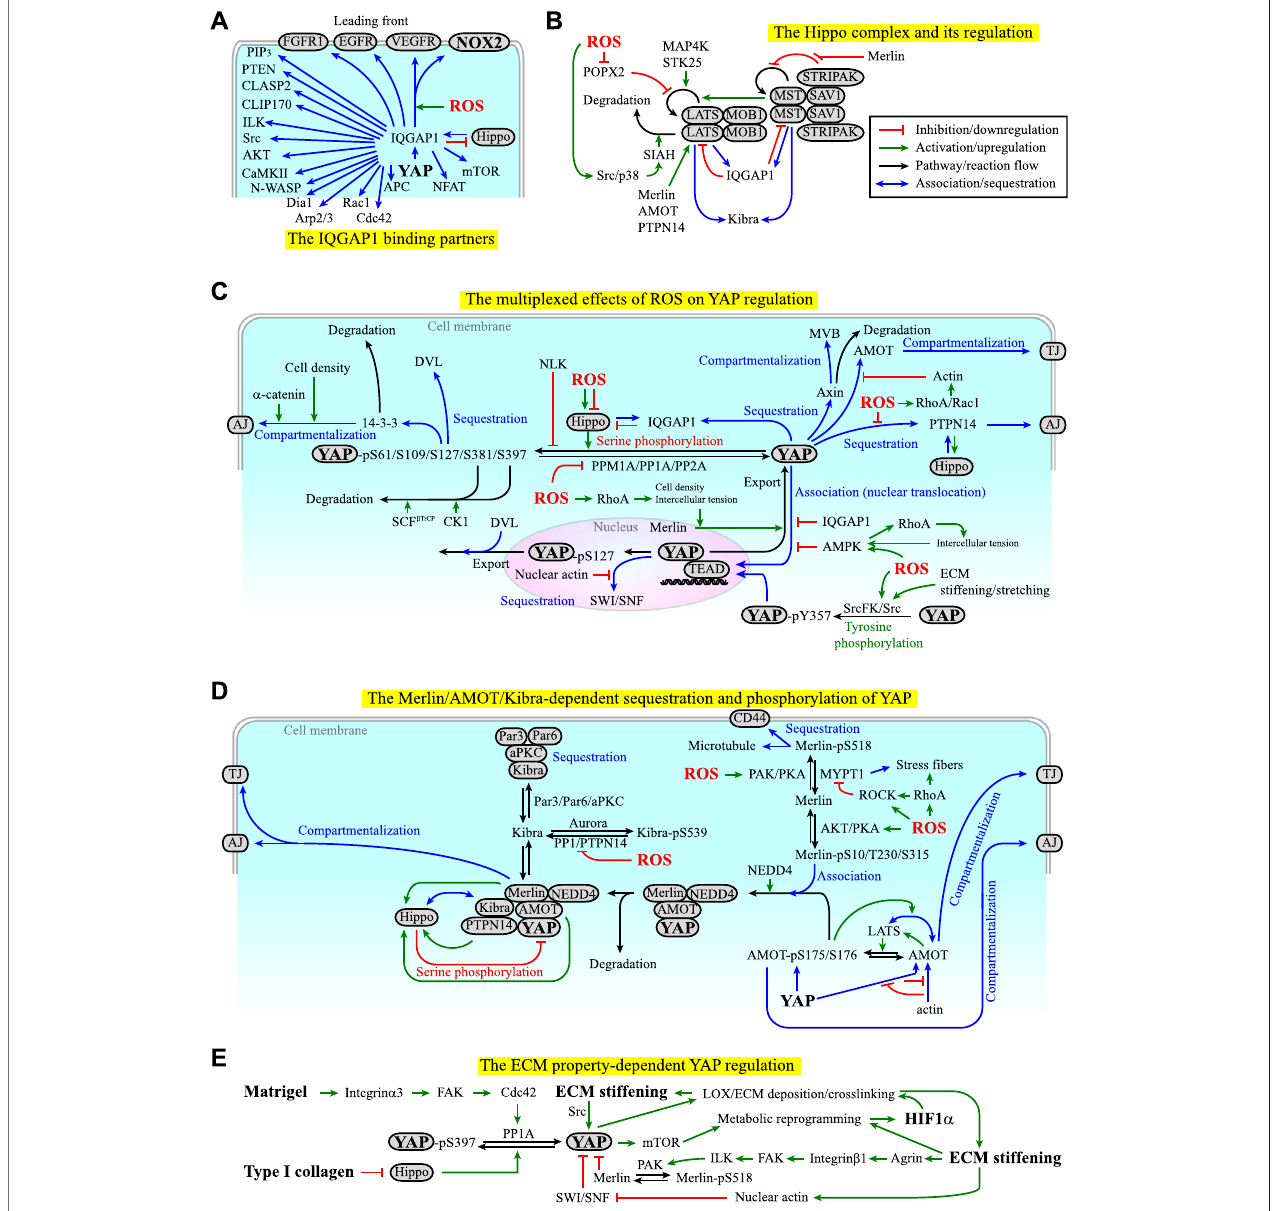
FIGURE 4 | (A) Examples of the binding partners of IQ motif-containing GTPase activating protein 1 (IQGAP1). Red lines indicate inhibition or downregulation. Green lines indicate activation or upregulation. Blue lines indicate physical association or recruitment. See Module Boxes IV and V for details. (B) The Hippo complex is regulatedbyitselfandseveralkinases,phosphatases,andmolecularscaffoldsinaROS-dependentmanner.SeeModuleBoxVfordetails.Blacklinesindicatethe fl owof the pathways, cascades, or a reaction. (C) ROS exhibit both positive and negative effects on the regulation of YAP signaling manifested in the phosphorylation, dephosphorylation, sequestration, degradation, and compartmentalization of YAP. Red texts indicate inhibition. Blue texts indicate sequestration, association, or compartmentalization. Green texts indicate activation. (D) Merlin, angiomotin (AMOT), kidney and brain expressed protein (KIBRA), and protein tyrosine phosphatase non-receptortype14(PTPN14)actwiththeHippocomplexandcytoskeletonstoregulatethephosphorylation,sequestration,compartmentalization,anddegradationof YAP inaROS-dependent manner. See Module BoxVfordetails. (E) The ECMcomponentsand mechanical propertiescanregulateYAPsignaling in aself-perpetuating manner. See Main Text and Module Box V for